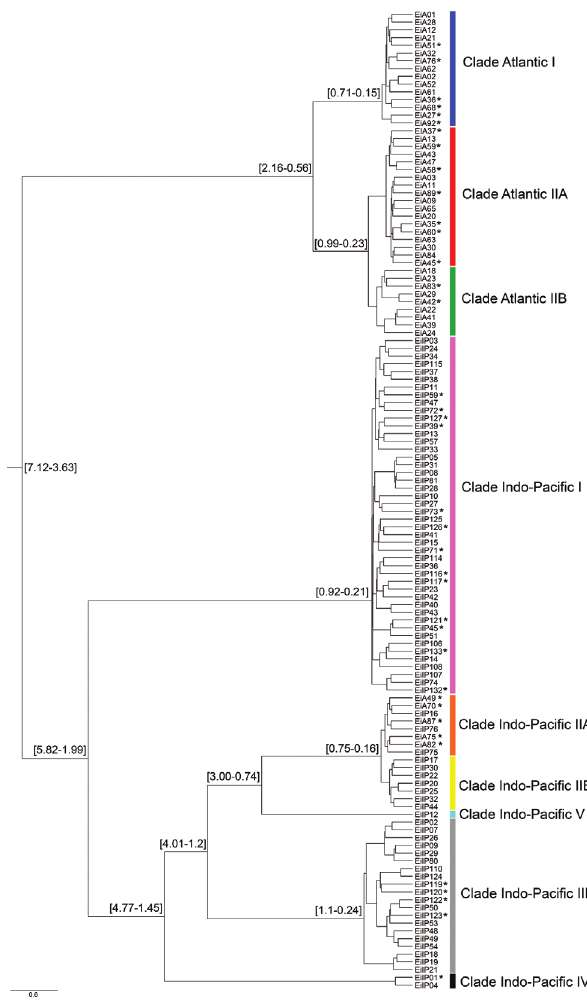
Figure 1 - Bayesian tree based on unique mitochondrial control region haplotypes (739 bp) of hawksbill turtles reported in literature from rooker- ies and foraging aggregations worldwide. The 95% highest posterior den- sity (HPD) interval TMRCA values calculated in BEAST are shown in each tree nodes. Branch lengths are proportional to time, with the horizon- tal axis given in millions of years. Asterisk: `orphan haplotypes’ (only found in foraging